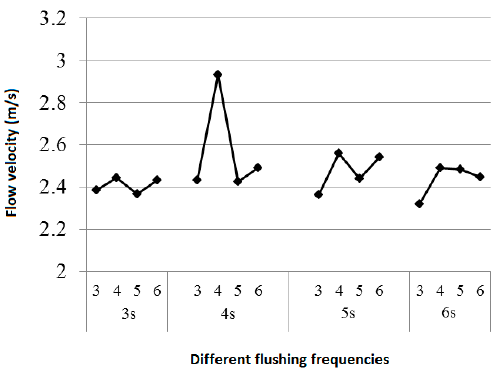
Figure 14. Flow velocity comparison of all the frequencies when the rectangular nozzle is in the middle.